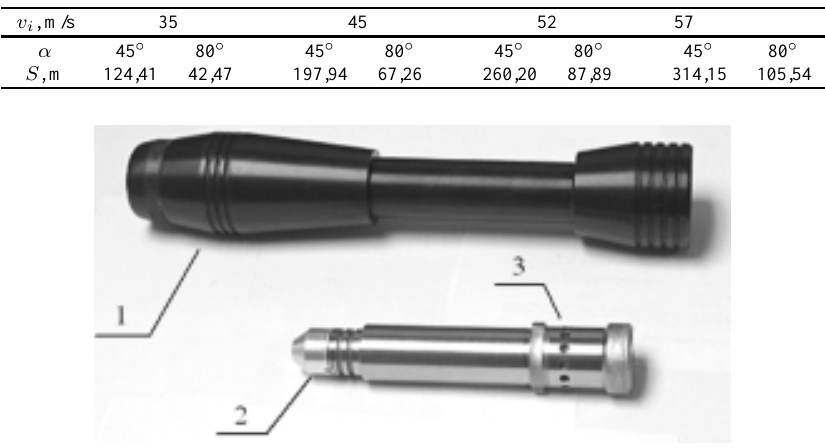
Fig. 3. 60 mm shell simulator: ballistic barrel – 1; warhead – 2; cartridge – 3.